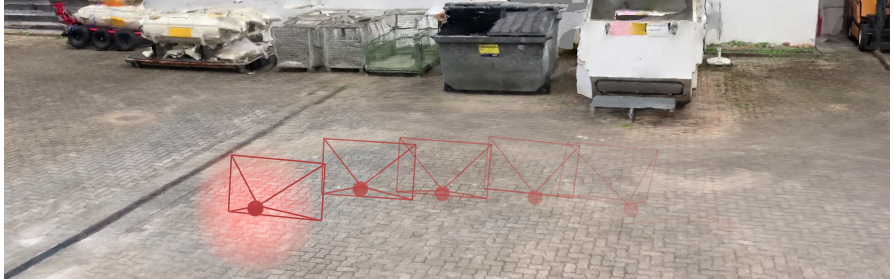
Figure 19. The user can configure the display of moving cameras in the scene. The location of the camera at the currently selected time is highlighted with a red halo. In this example, the camera locations of the last four time steps are also shown with increasing